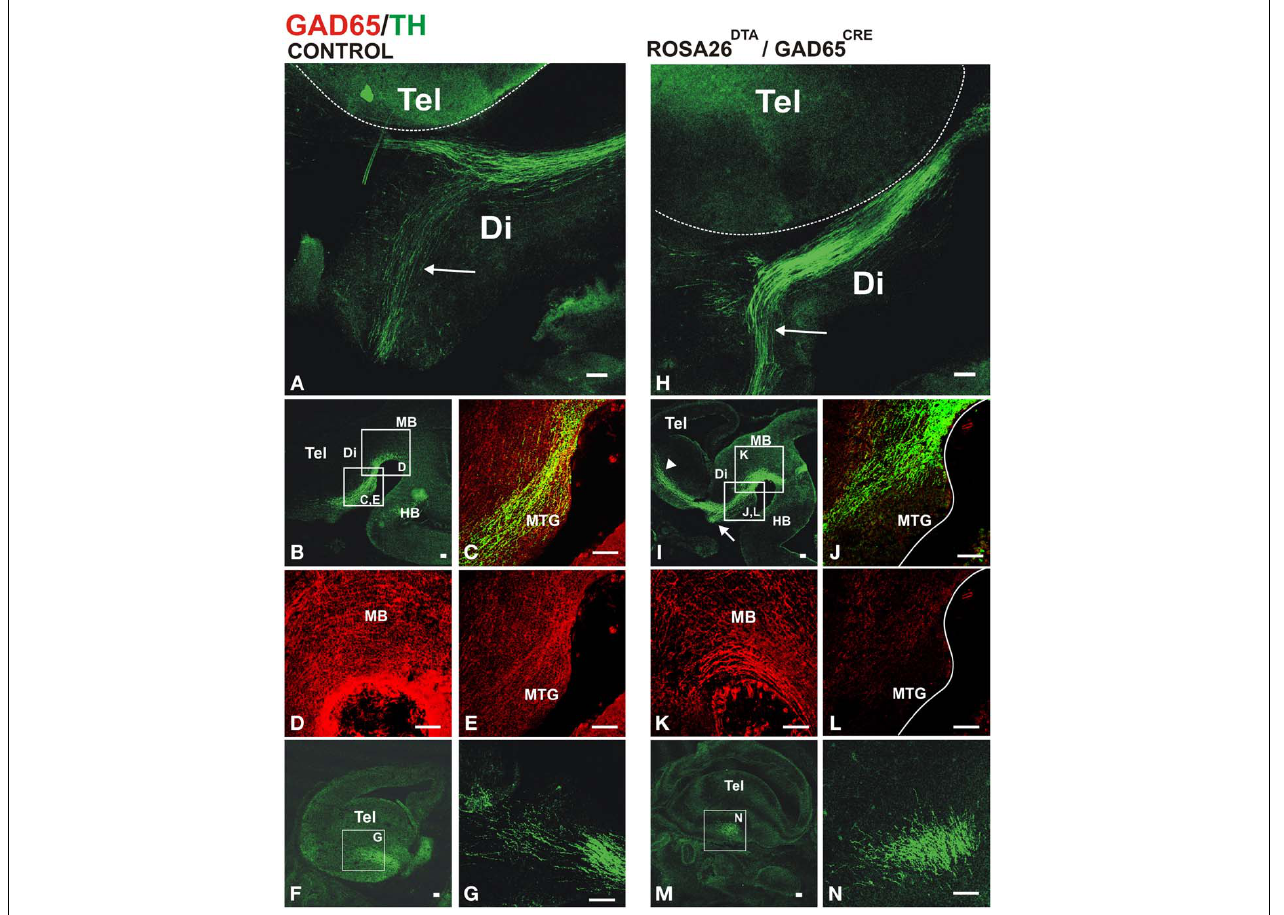
FIGURE 4 | Conditional depletion of GAD65 axon fibers alters dopaminergic meso-striatal projection. Brains or sections of E13.5 control mouse embryos ( ROSA26 DTA / + , A–G ) or of embryos carrying both alleles ( ROSA26 DTA / + :GAD65 CRE / + , H–N) were immunostained for GAD65 (red) and TH (green). (A,H) are views of flat-mounted hemibrains showing the more abundantventralprojectioninembryoscarryingbothalleles(arrows), (B–E,I–L)